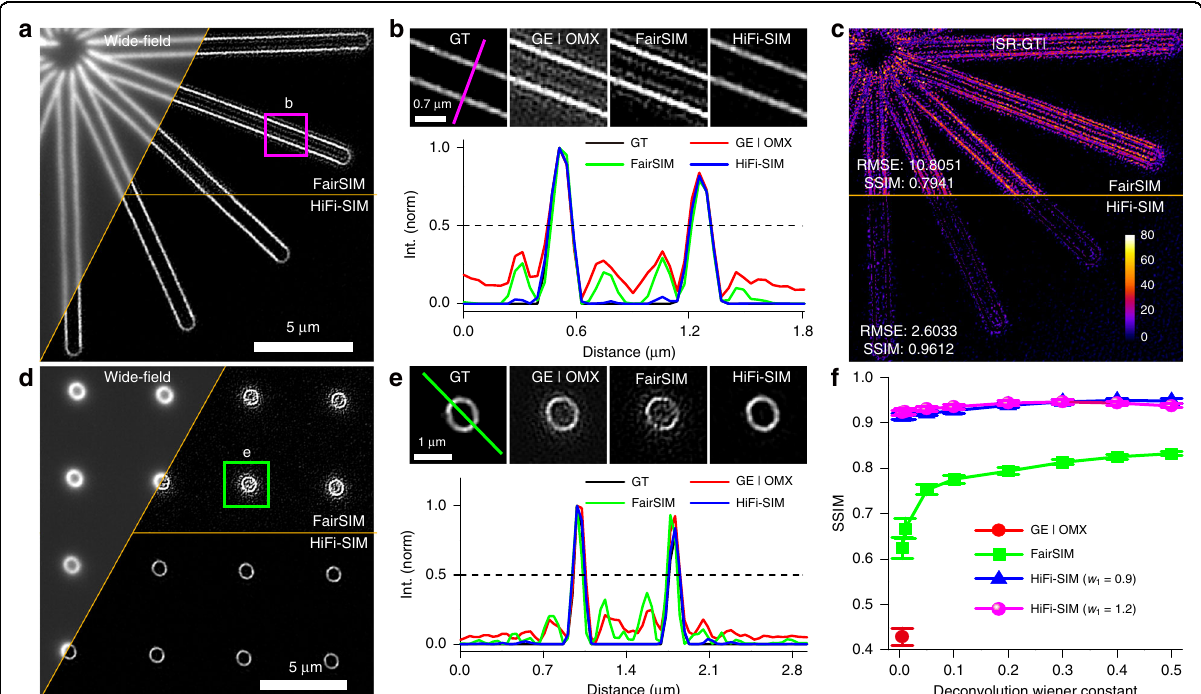
Fig. 3 Quantitative characterization of the fi delity of HiFi-SIM reconstruction. a “ Start ” patterns in Argolight slide were imaged by DeltaVision OMX with 5 ms exposure. The equivalent wide- fi eld image is shown in the upper-left, and the SR images of fairSIM and HiFi-SIM are presented in the upper-right and lower-right corners, respectively. b Magni fi ed SR images reconstructed from the magenta-box region in a using GE SoftWoRx, fairSIM, and HiFi-SIM. The ground-truth (GT) is shown on left, which is reconstructed by HiFi-SIM from the same region of high-quality data with 50 ms exposure. Intensity pro fi les along the magenta line in b con fi rm that HiFi-SIM eliminates almost all sidelobe artifacts around the real lines. c Error-map of the SIM images to the ground-truth model. RMSE and SSIM values are shown in the lower-left corner. d , e Comparison of the SR images for “ ring ” patterns in Argolight slide with 10 ms exposure time, reconstructed by fairSIM, HiFi-SIM, and SoftWoRx. f SSIM plot of reconstructed SR results vs. the ground-truth model, with different reconstruction